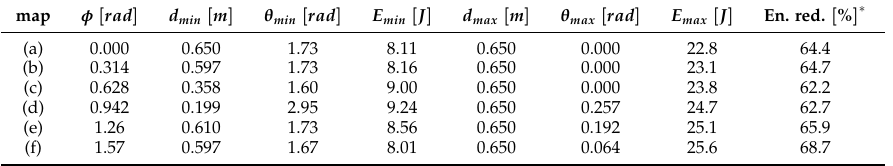
Table 4. Minimum and maximum energy solutions for Case (1). ∗ Energy reduction w.r.t. E max